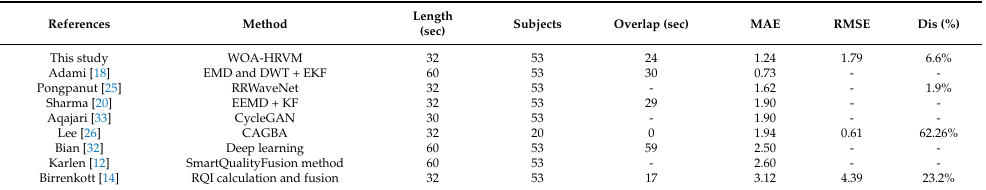
Table 6. Performance comparison of different PPG-signal-based respiration rate detection methods on BIDMC